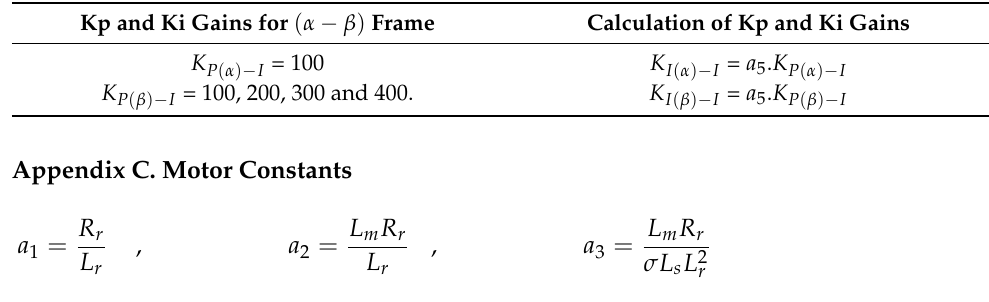
Table A2. Parameters of PI current controller using the trial and error method.